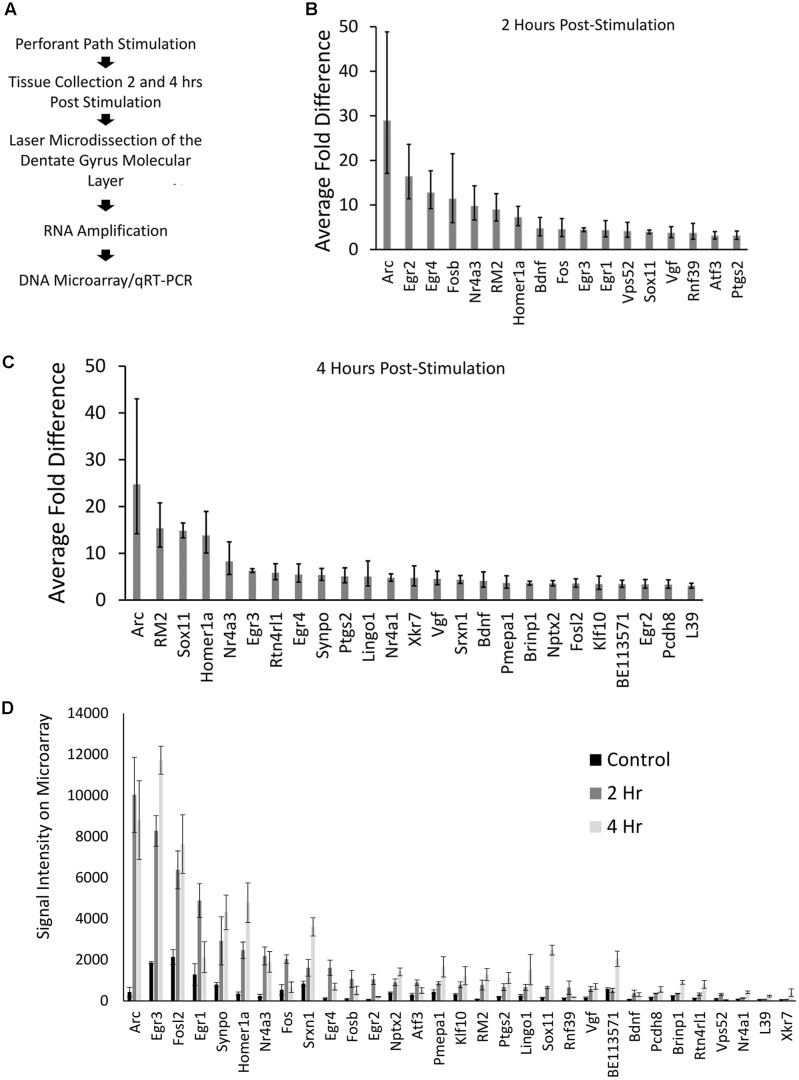
(A) Stepwise outline of experiment from surgery to DNA microarray. (B) Microarray results for 2 h post-pp-HFS, compared to controls, depicted as fold change. Error bars represent standard deviation (SD), n = 3 per group. (C) Microarray results for 4 h post pp-HFS, compared to controls, depicted as fold change. Error bars represent SD, n = 3 per group. (D) Raw signal intensity from DNA microarray for control, 2 h, and 4 h samples. Error bars represent standard error of the mean (SEM), n = 3 per group.